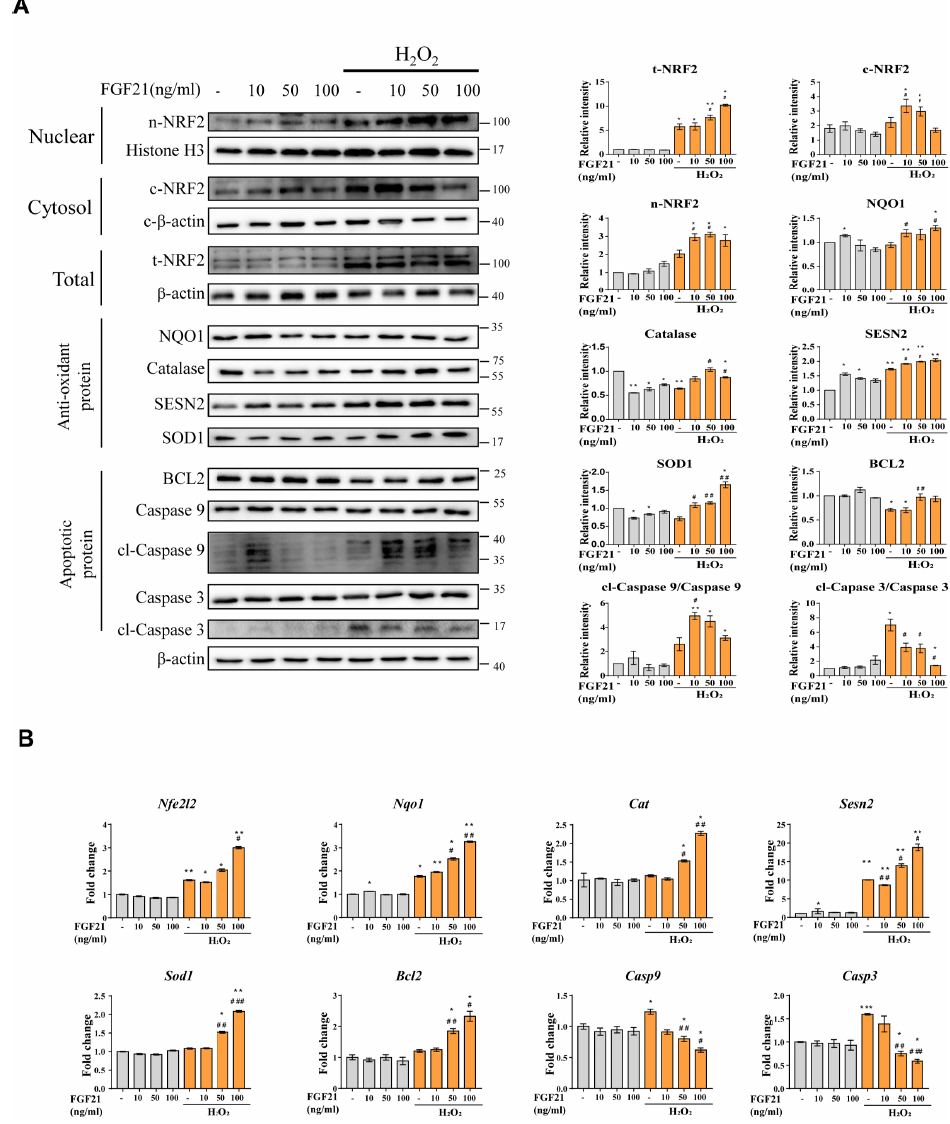
Figure 6. Effect of FGF21 treatment on H 2 O 2 -induced oxidative stress and apoptosis in H9c2 cells. Assessment of the differential expressed antioxidant/apoptotic factors by western blot ( A ) and qPCR ( B